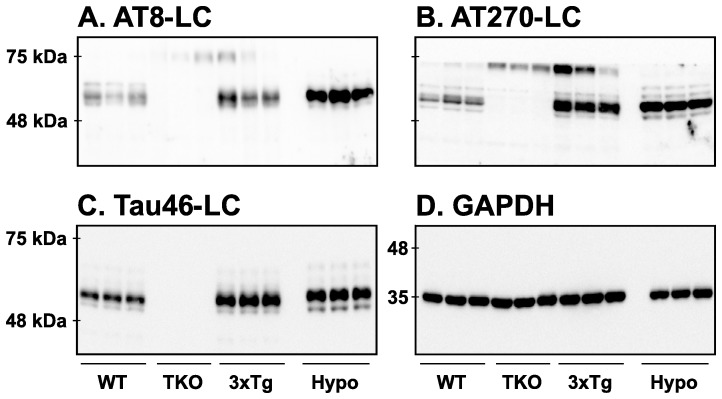
Analysis of tau signal with anti-mouse light chain secondary antibodies by Western blotting.The proteins were extracted form the cortex of 3 mouse lines: control mice (WT and Hypothermic), Tau KO mice and 3xTg mice with n = 3 for each group. Proteins were extracted with SDS-PAGE and then identified with the following commercial monoclonal antibodies: A: AT8, B: AT270, C: Tau46 and D: GAPDH. We used one antibodies of each non-specificity category (AT8 for high non-specificity, AT270 for moderate non-specificity and Tau46 for absence of non-specificity). Anti-mouse light chain secondary antibodies were used to detect primary antibodies except for GAPDH. Quantifications of the blots are available in Figure S4.